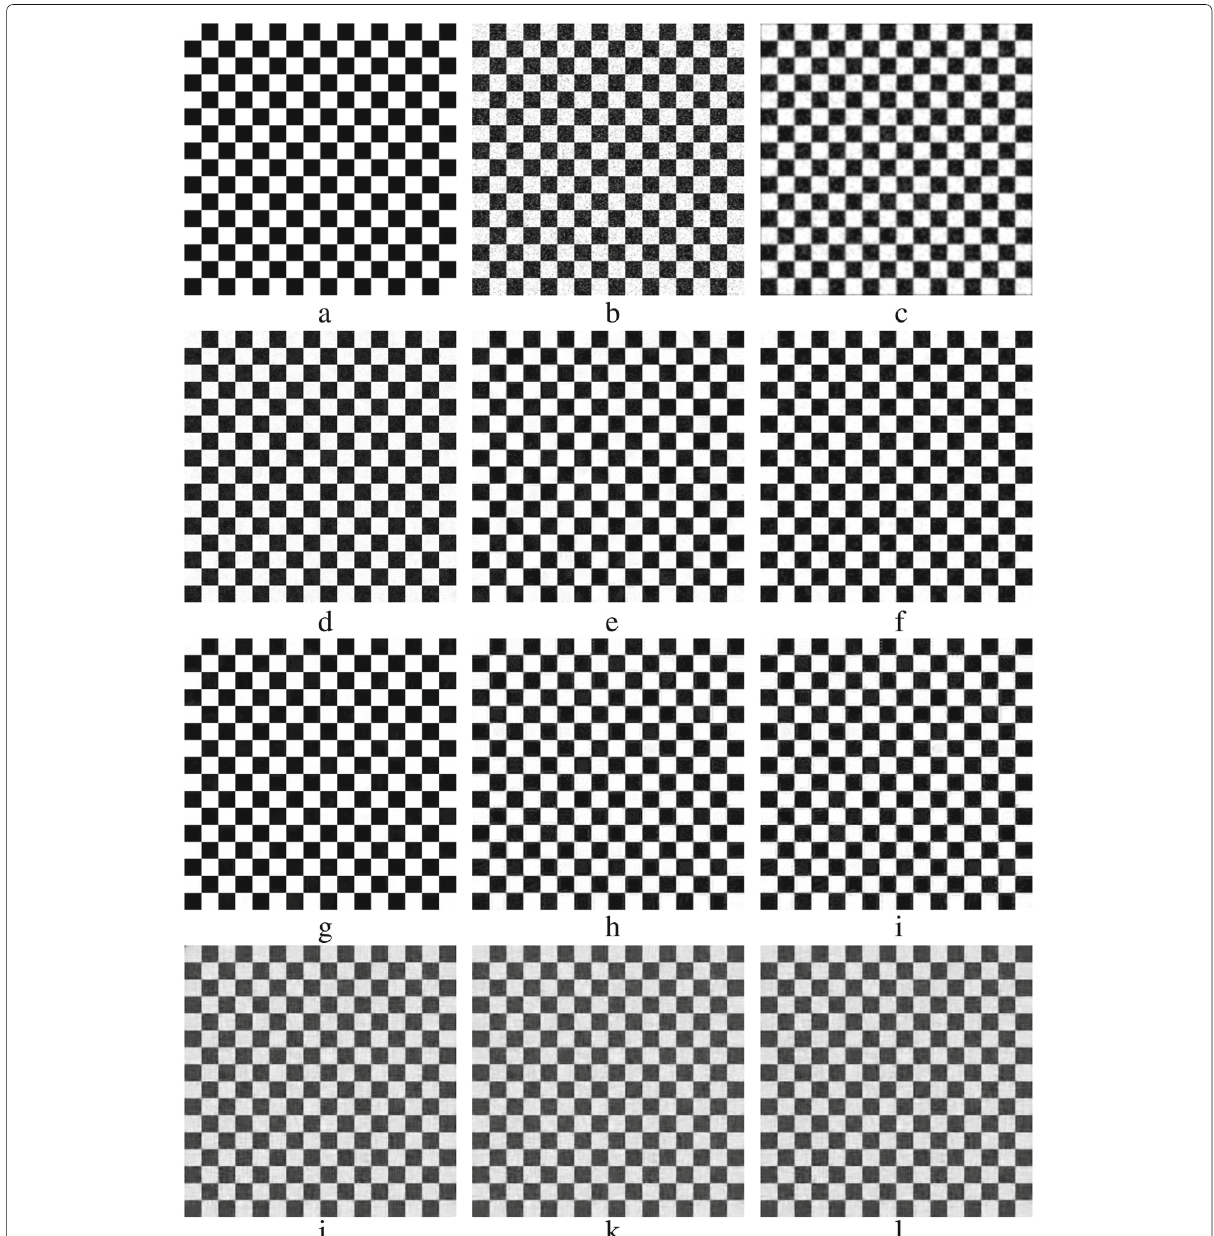
Fig. 21 Denoised Chessboard images: a original Chessboard image; b AWG noise, σ = 40; c AD (Perona & Malik); d bilateral filtering; e NL-Means filtering; f K-SVD; g BM3D; h Non-itPPB; i It-PPB; j PGPCA; k PLPCA; and l